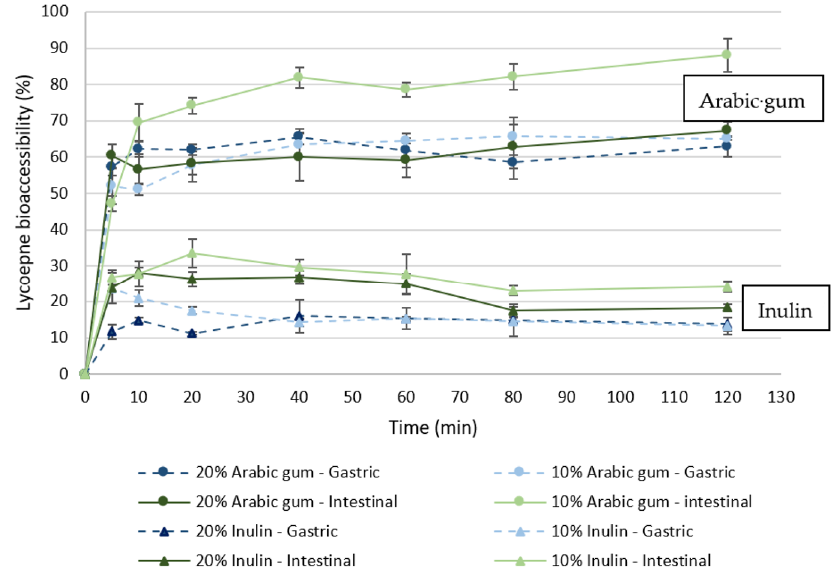
Figure 3. In vitro release profiles of lycopene from microparticles of inulin and arabic gum, under static conditions, in simulated gastric and intestinal